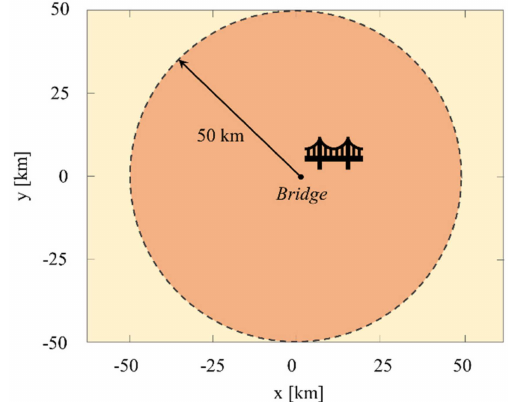
Figure 4. Bridge and seismogenic